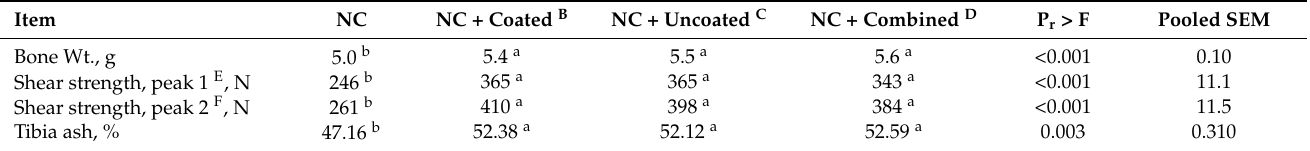
Table 4. Influence of negative control (NC), coated phytase supplementation (NC + 1000 FTU A coated phytase), uncoated phytase supplementation (NC + 1000 FTU uncoated phytase), and combined